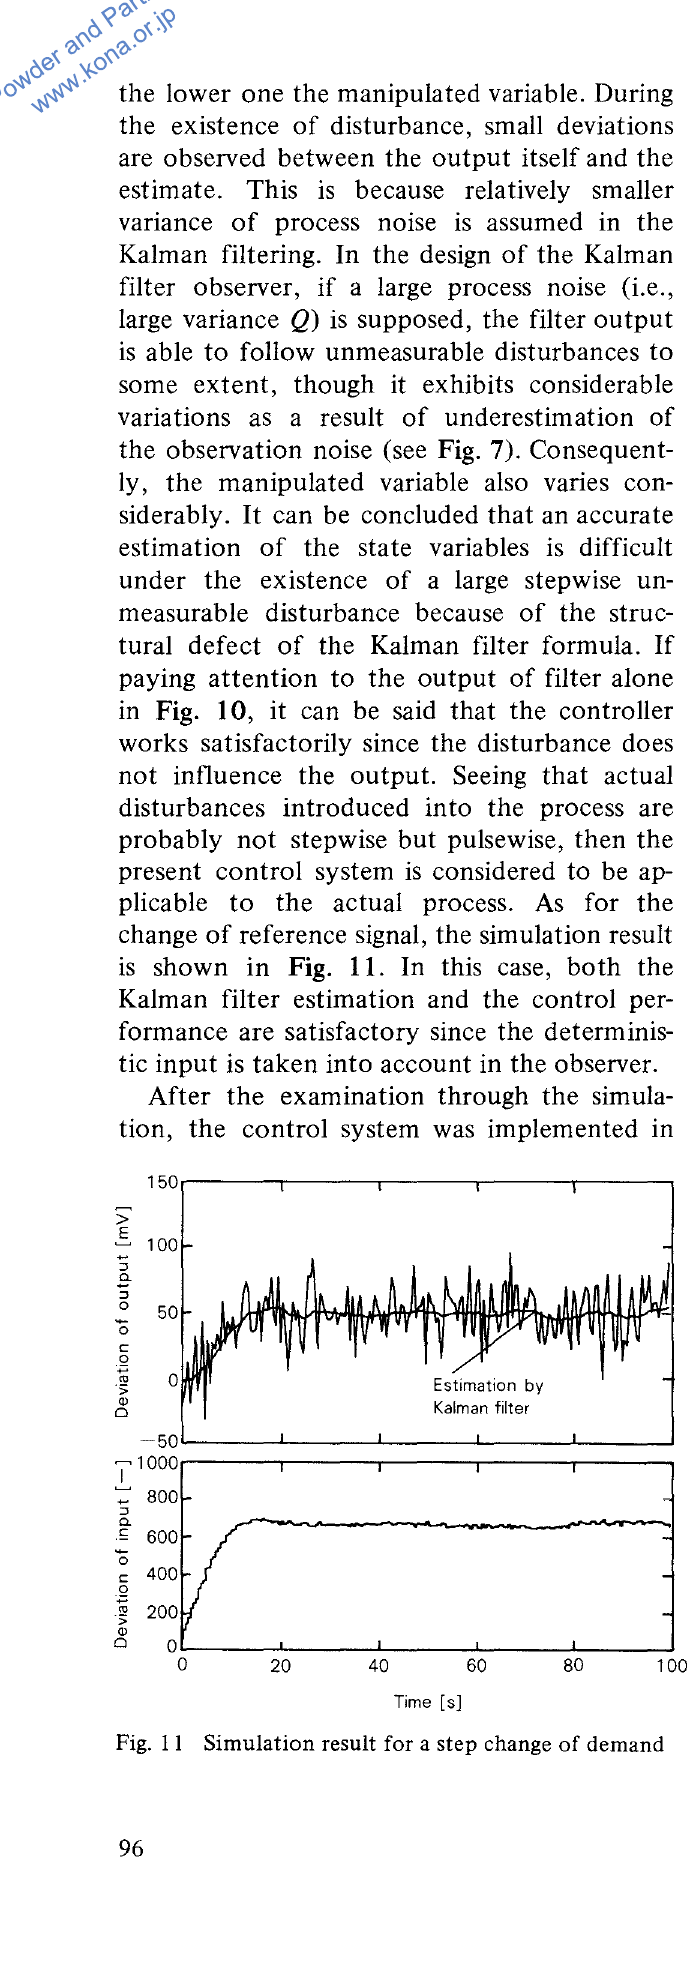
Fig. 11 Simulation result for a step change of demand